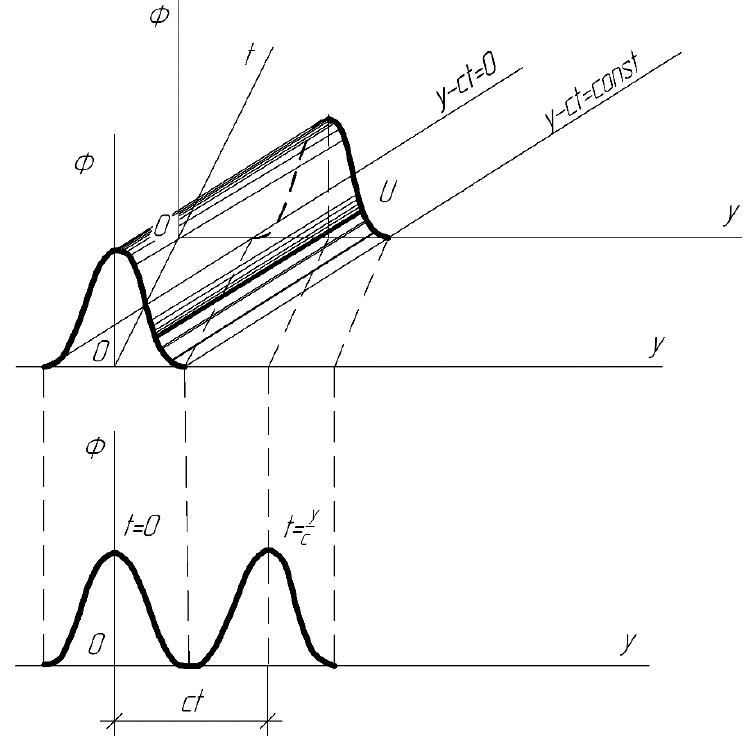
Figure 4. Velocity potential of pressure acoustic wave.